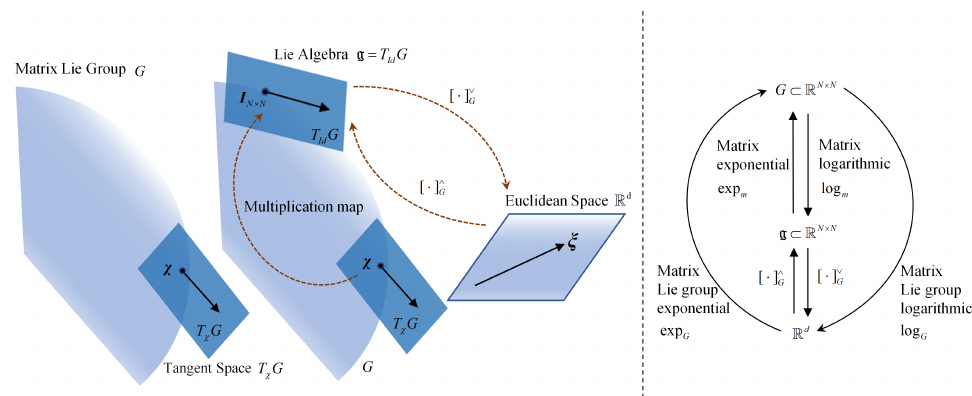
Figure 1. Schematic of mappings among Lie group, Lie algebra, and Euclidean space. Lie group model is oversimplified. Two distinct identifications of tangent space T χ G at χ with tangent space T I G at I N × N afforded by left or right Lie multiplication. Multiplication map includes left and right